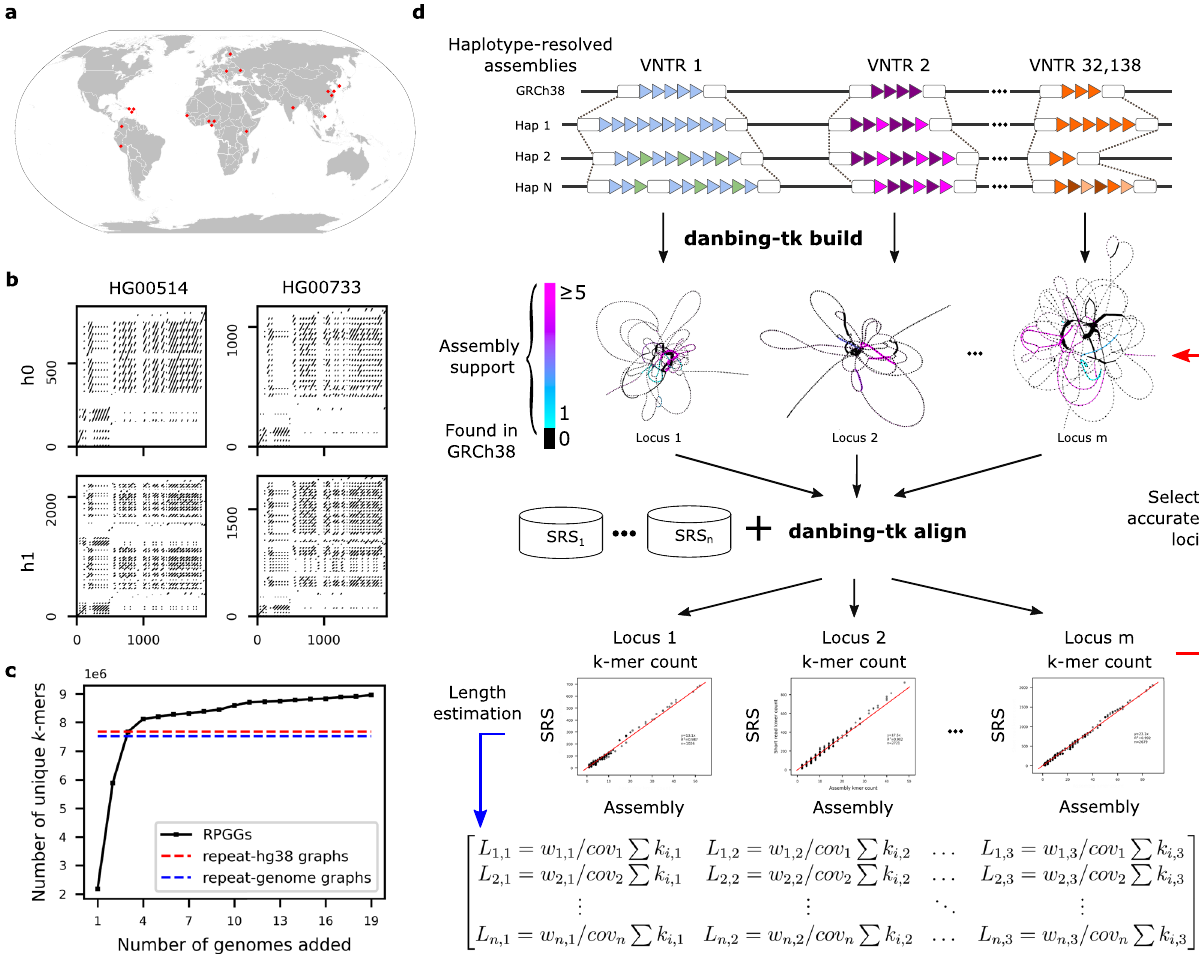
Fig. 1 Sequence diversity of VNTRs in human populations. a Global diversity of long-read assemblies. b Dot-plot analysis of the VNTR locus incorporated, measured by the number of k -mers in the 32,138 VNTR graphs. Total graph size built from GRCh38 and an average genome are also shown. d Danbing-tk work fl ow analysis. (top) VNTR loci de fi ned from the reference are used to map haplotype loci. Each locus is converted to a de Bruijn graph, from which the collection of graphs is the RPGG. The de Bruijn graphs shown illustrate sequences missing from the RPGG built only on GRCh38. The alignments may be either used to select which loci may be accurately mapped in the RPGG using SRS that match the assemblies (red), or may be used to estimate lengths on sample datasets (blue). Source data are provided as a Source Data fi